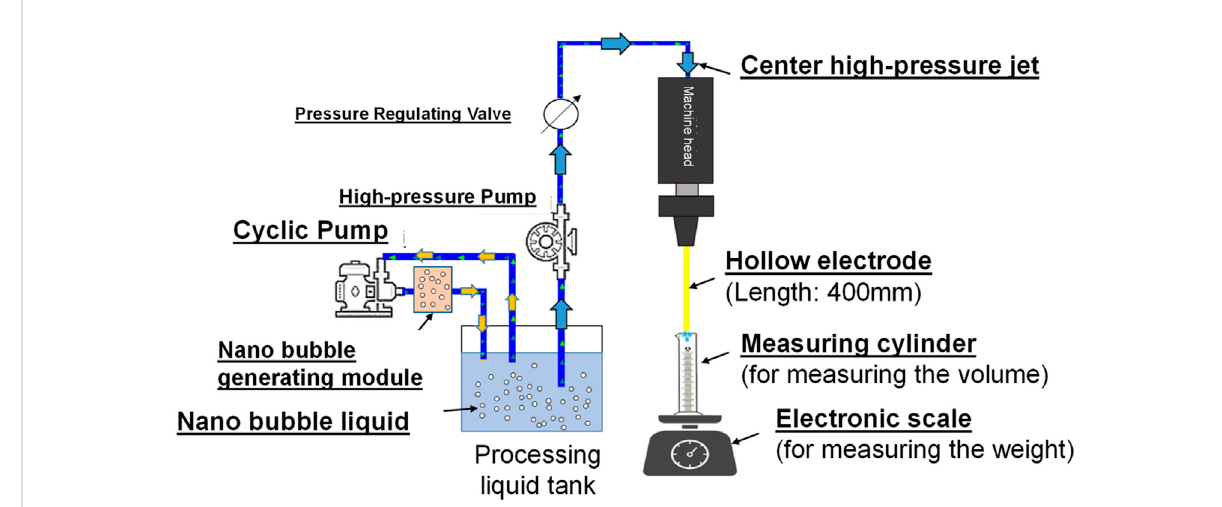
FIGURE 13 System layout showing the nanobubbles in Pore Discharge Machine jet test.